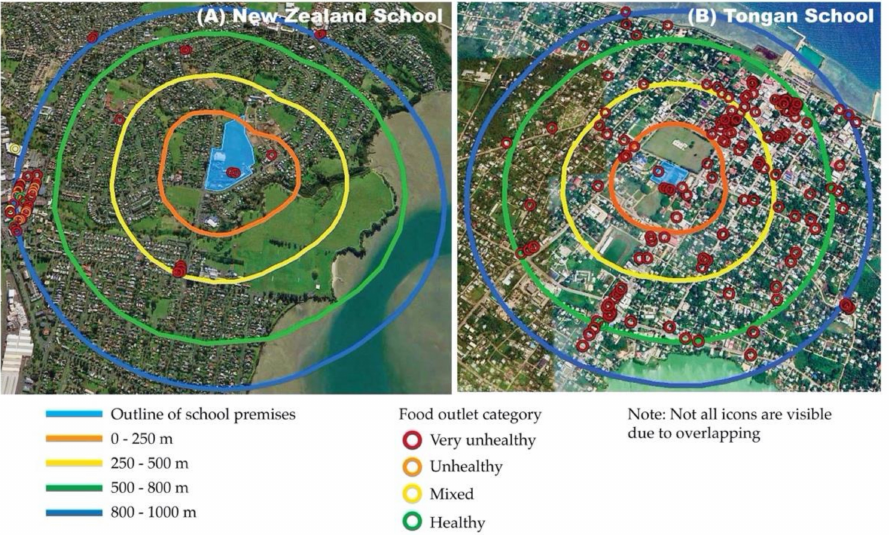
Figure 2. Food outlets within 1 km of ( A ) Setting A–the school in Auckland, NZ and ( B ), Setting B, the school in Nuku’alofa, Tonga; via Google Earth Pro